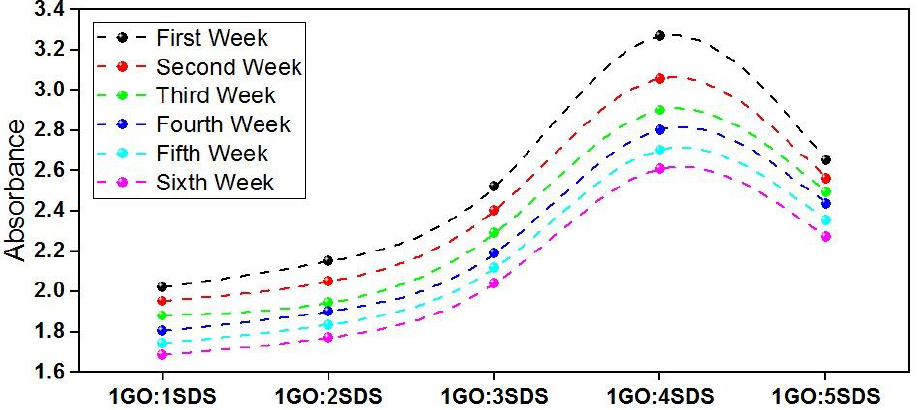
Figure 4. Absorbance of CO-based various ratios of GO:SDS samples over a period of six weeks.